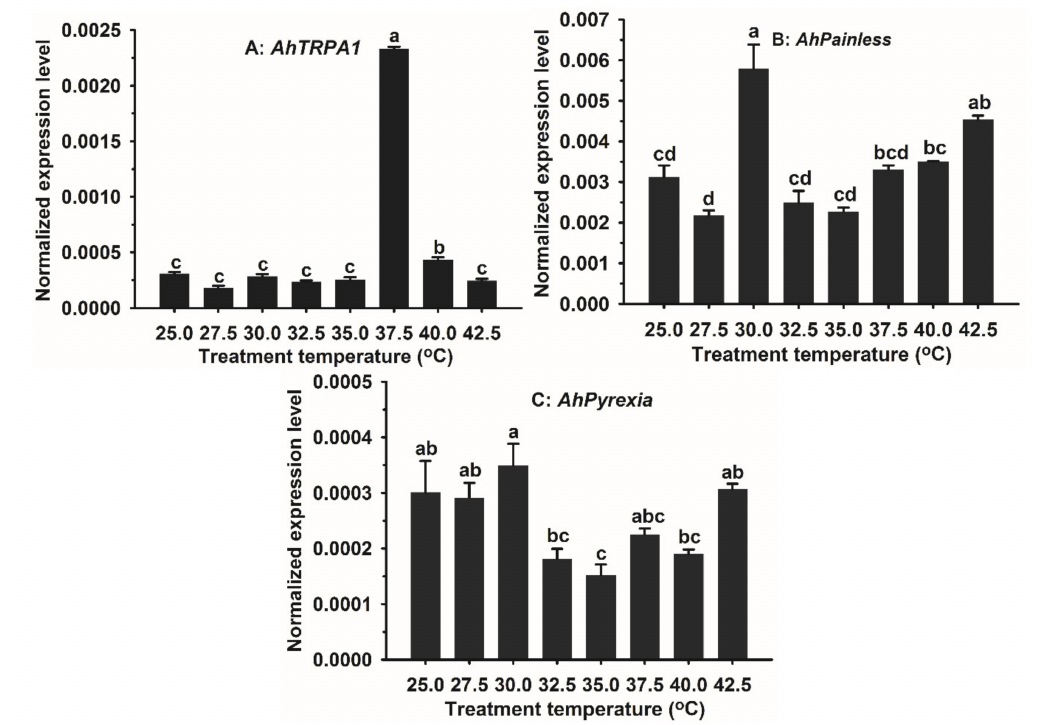
Figure 4. Impacts of temperature on the expression of ( A ) AhTRPA1 , ( B ) AhPainless , and ( C ) AhPyrexia in Agasicles hygrophila eggs. Each treatment included three biological replicates. Data of the bar chart are represented by mean ± SE. Di ff erences in expression at di ff erent high temperatures were analyzed using one-way ANOVA and Turkey’s HSD test. Di ff erent lowercase letters represent significant di ff erence at p <